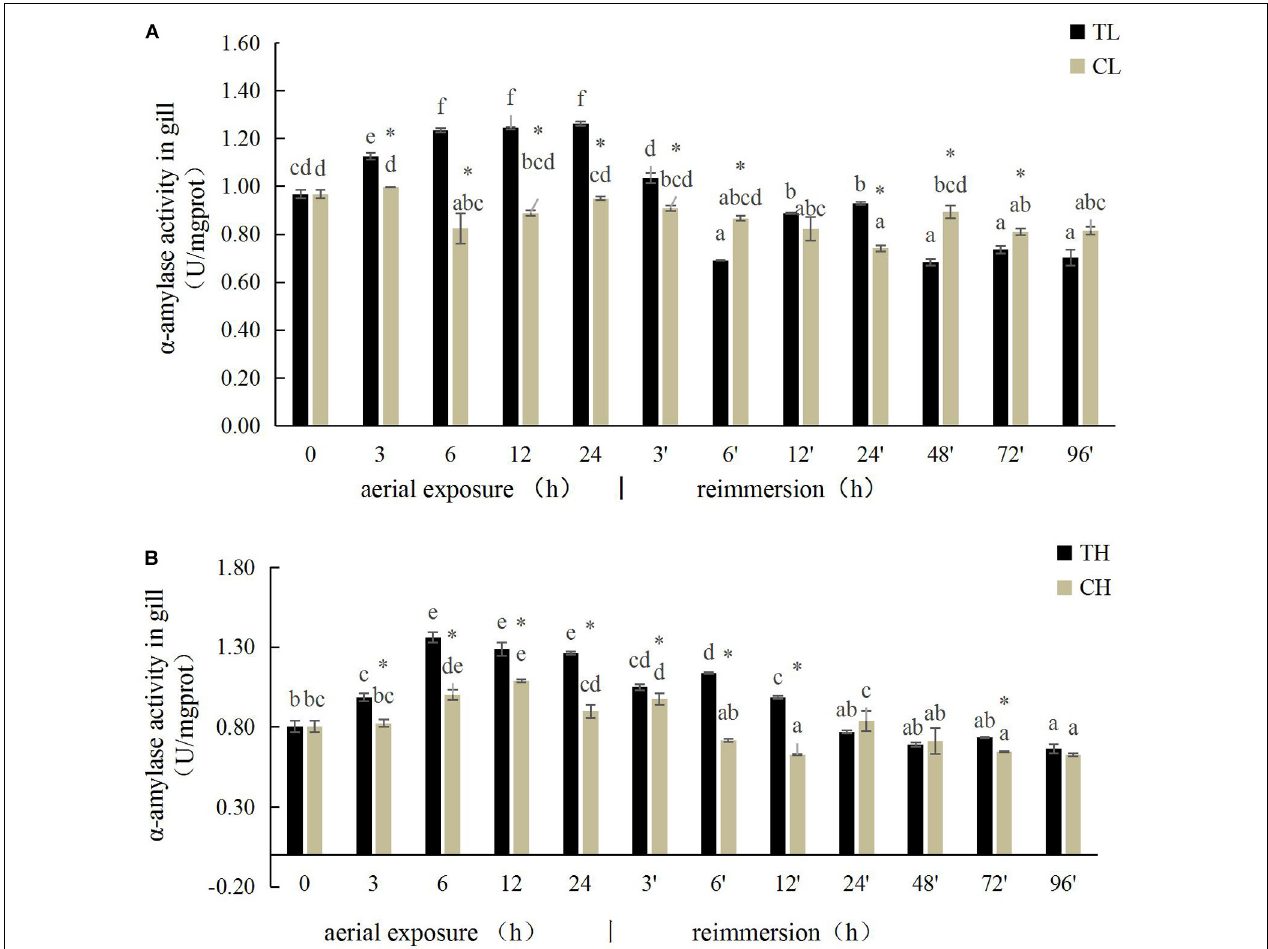
FIGURE 1 | Effects of aerial exposure on α -amylase in gill of Ruditapes philippinarum under low temperature (A) and high temperature (B) . TL, low temperature experimental group; CL, low temperature control group; TH, high temperature experimental group; CH, high temperature control group. Asterisk represents significant difference in independent t -test in the control group at the same time; same lowercase letters are not significant, and different lowercase letters for difference. The same below.